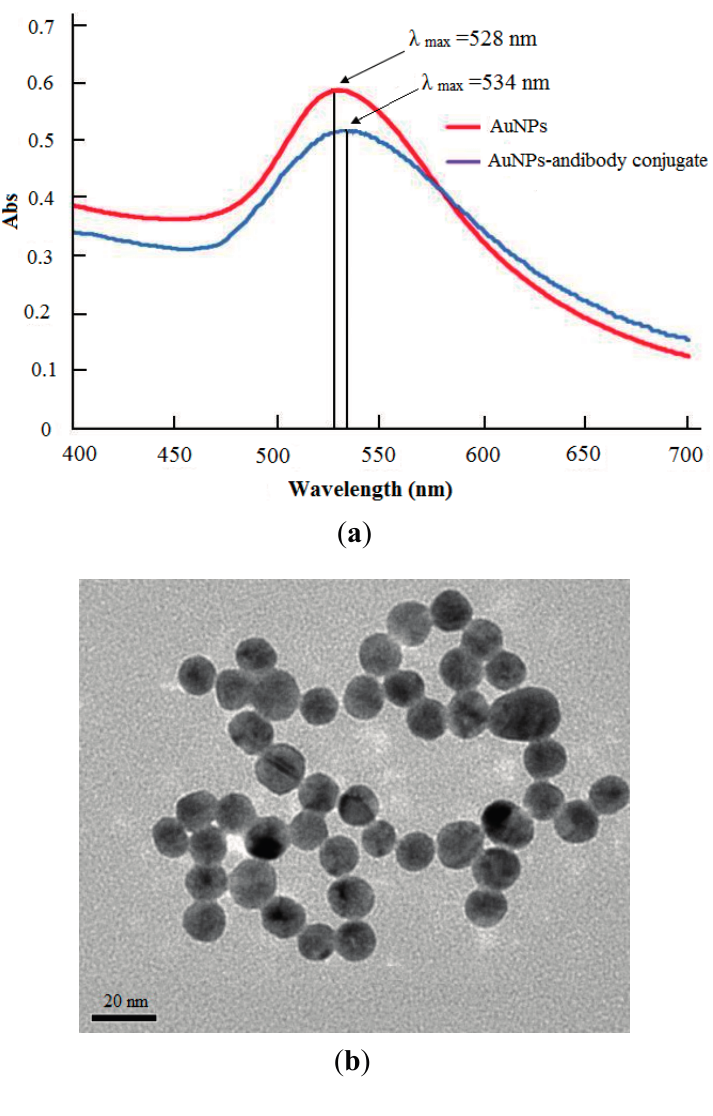
Figure 2. ( a ) The spectra of colloidal gold (red line) and antibody-colloidal gold conjugate (blue line); ( b ) TEM image of 20 nm gold